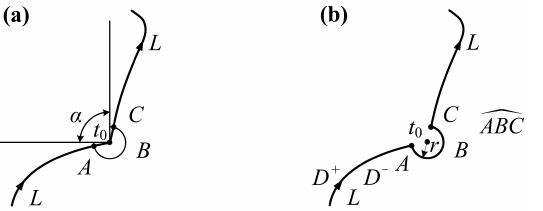
Figure 1. ( a ) The piecewise arc ABC of contour L with a corner point t 0 and ( b ) the arc ABC of smooth contour L .